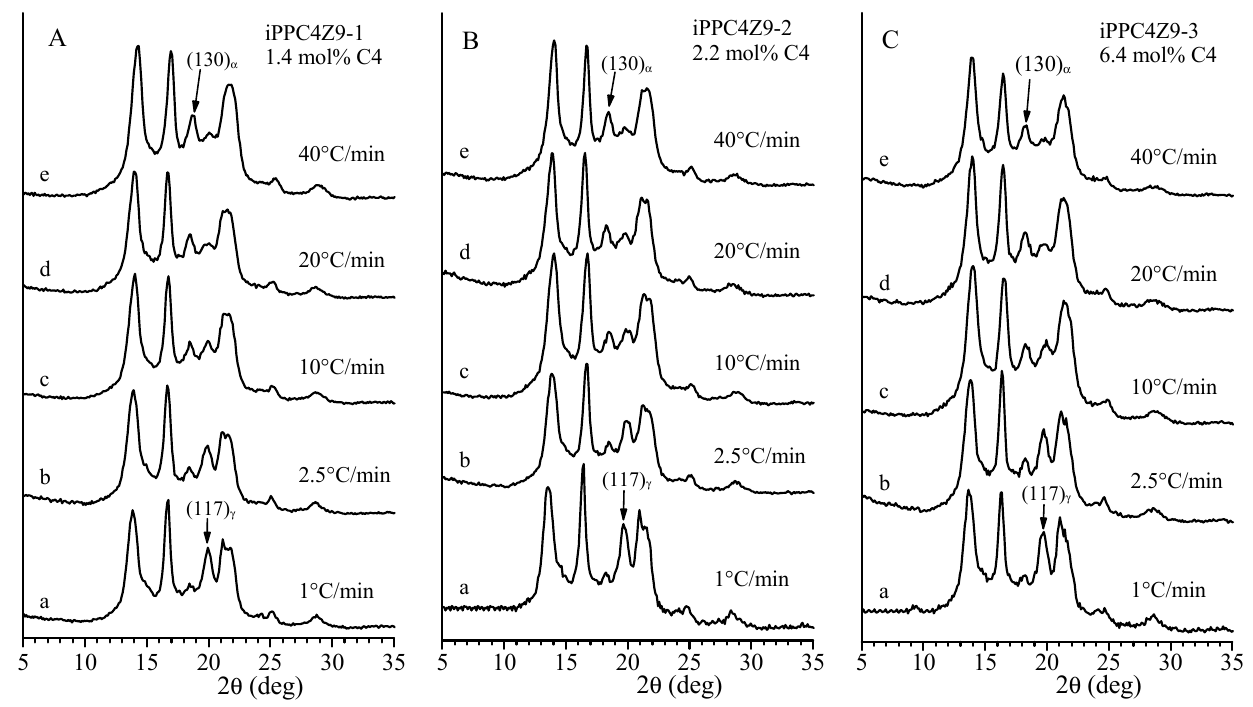
Figure 8. X-ray diffraction profiles of samples of copolymers iPPC4Z9-x crystallized from the melt by cooling the melt from 170 °C down to 25 °C at the indicated different cooling rates. These results demonstrate that in iPP samples containing significant concentrations of defects, such as stereodefects and butene comonomeric units, the γ form is the thermody- namically stable form of iPP and crystallizes normally from polymer solution or in selective conditions of very slow crystallization, as isothermal crystallizations from the melt at high crystallization temperatures [79] or by cooling from the melt at very low cooling rates, whereas the α form is the kinetically favored form and crystallizes in conditions of fast crystallization, such as fast cooling from the melt.